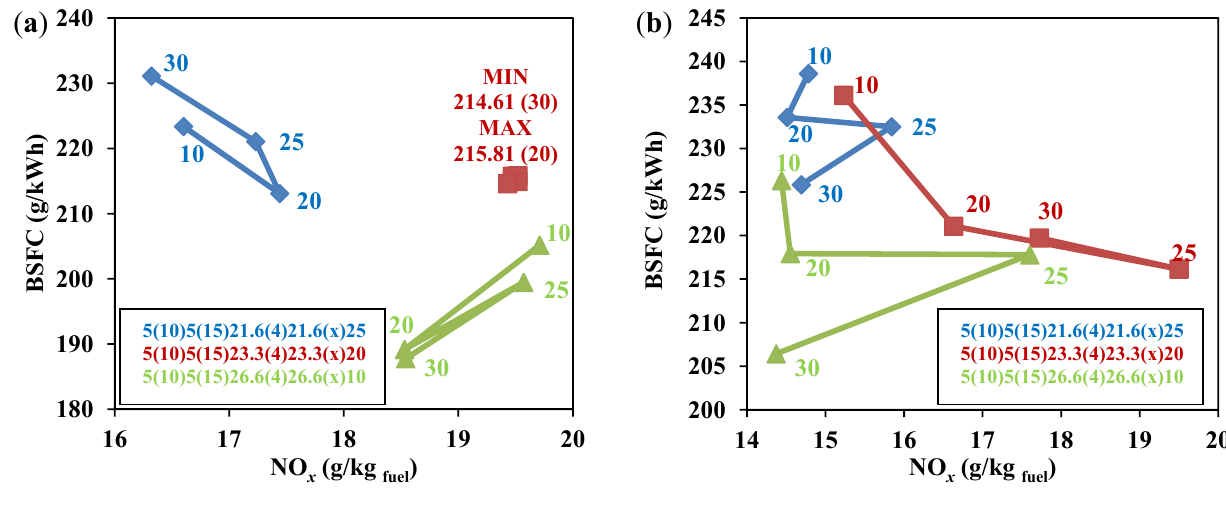
trade-off for ( a ) 10% and ( b ) 20% x